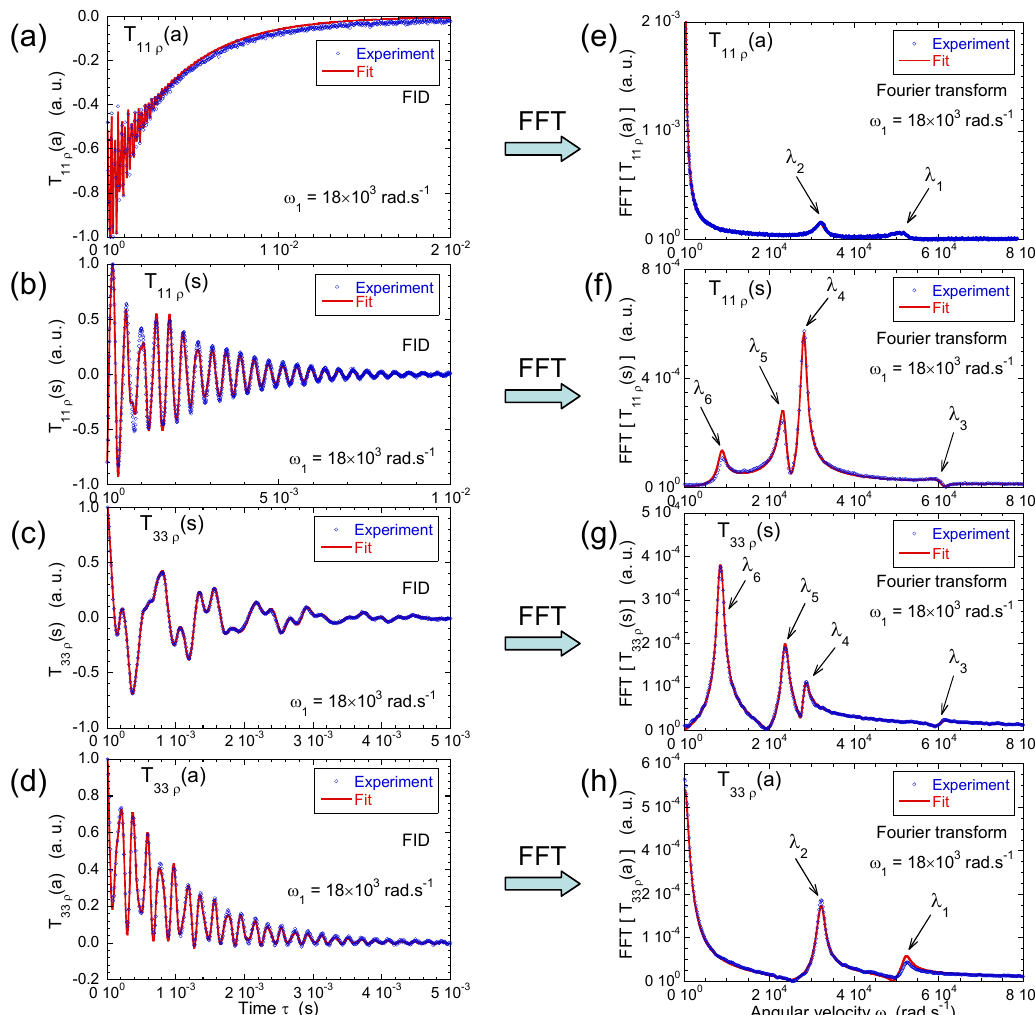
Figure 9. For Li + ions in concentrated laponite dispersion, the comparison between the experimental and fitted time evolution of the coherences: ( a ) T 11 ( a ) ; ( b ) T 11 ( s ) ; ( c ) T 33 ( s ) and ( d ) T 33 ( a ) coherences measured under spin-lock conditions, denoted T 11 ρ ( a ) , T 11 ρ ( s ) , T 33 ρ ( s ) and T 33 ρ ( a ) , respectively, and their Fourier transforms for ( e ) T 11 ( a ) ; ( f ) T 11 ( s ) ; ( g ) T 33 ( s ) and ( h ) T 33 ( a ) coherences ( 7 Li NMR). Reprinted with permission from [54]. Copyright (2009) American Chemical